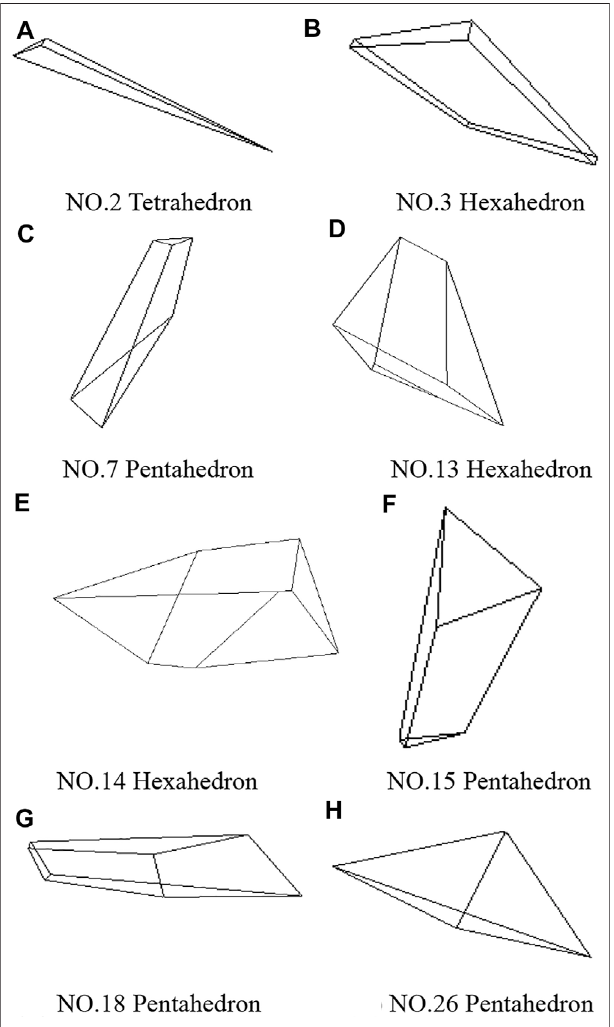
FIGURE 17 | The shape of key blocks. (A) No. 2 tetrahedron. (B) No. 3 hexahedron. (C) No. 7 pentahedron. (D) No. 13 hexahedron. (E) No. 14 hexahedron. (F) No. 15 pentahedron. (G) No. 18 pentahedron. (H) No. 26 pentahedron.